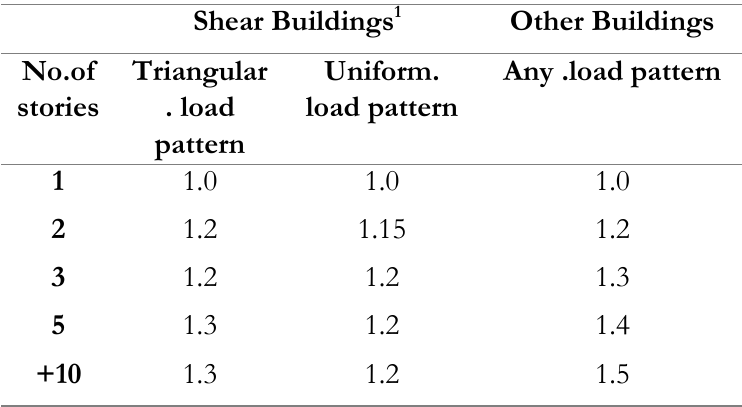
Table 5. Modification Factor Co